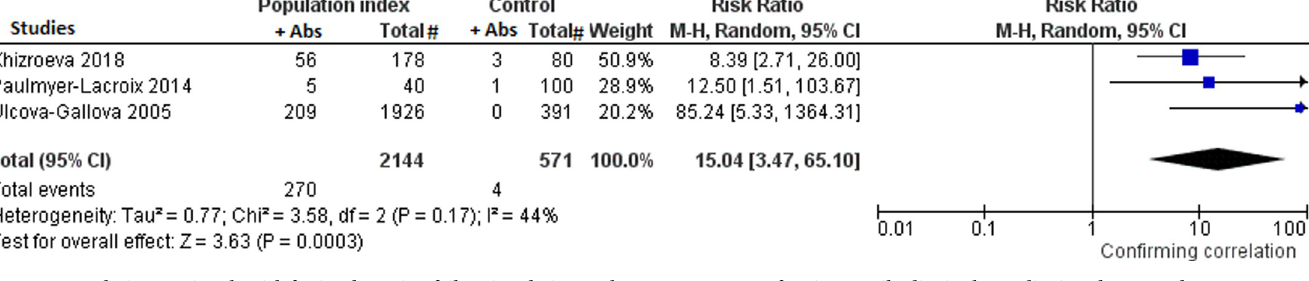
PLOS ONE | https://doi.org/10.1371/journal.pone.0260759 July 27,